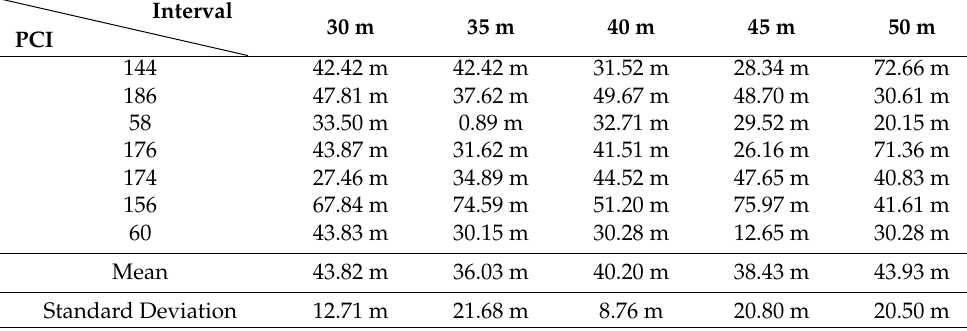
Table 1. Summary of positioning errors according to interval of grid points.